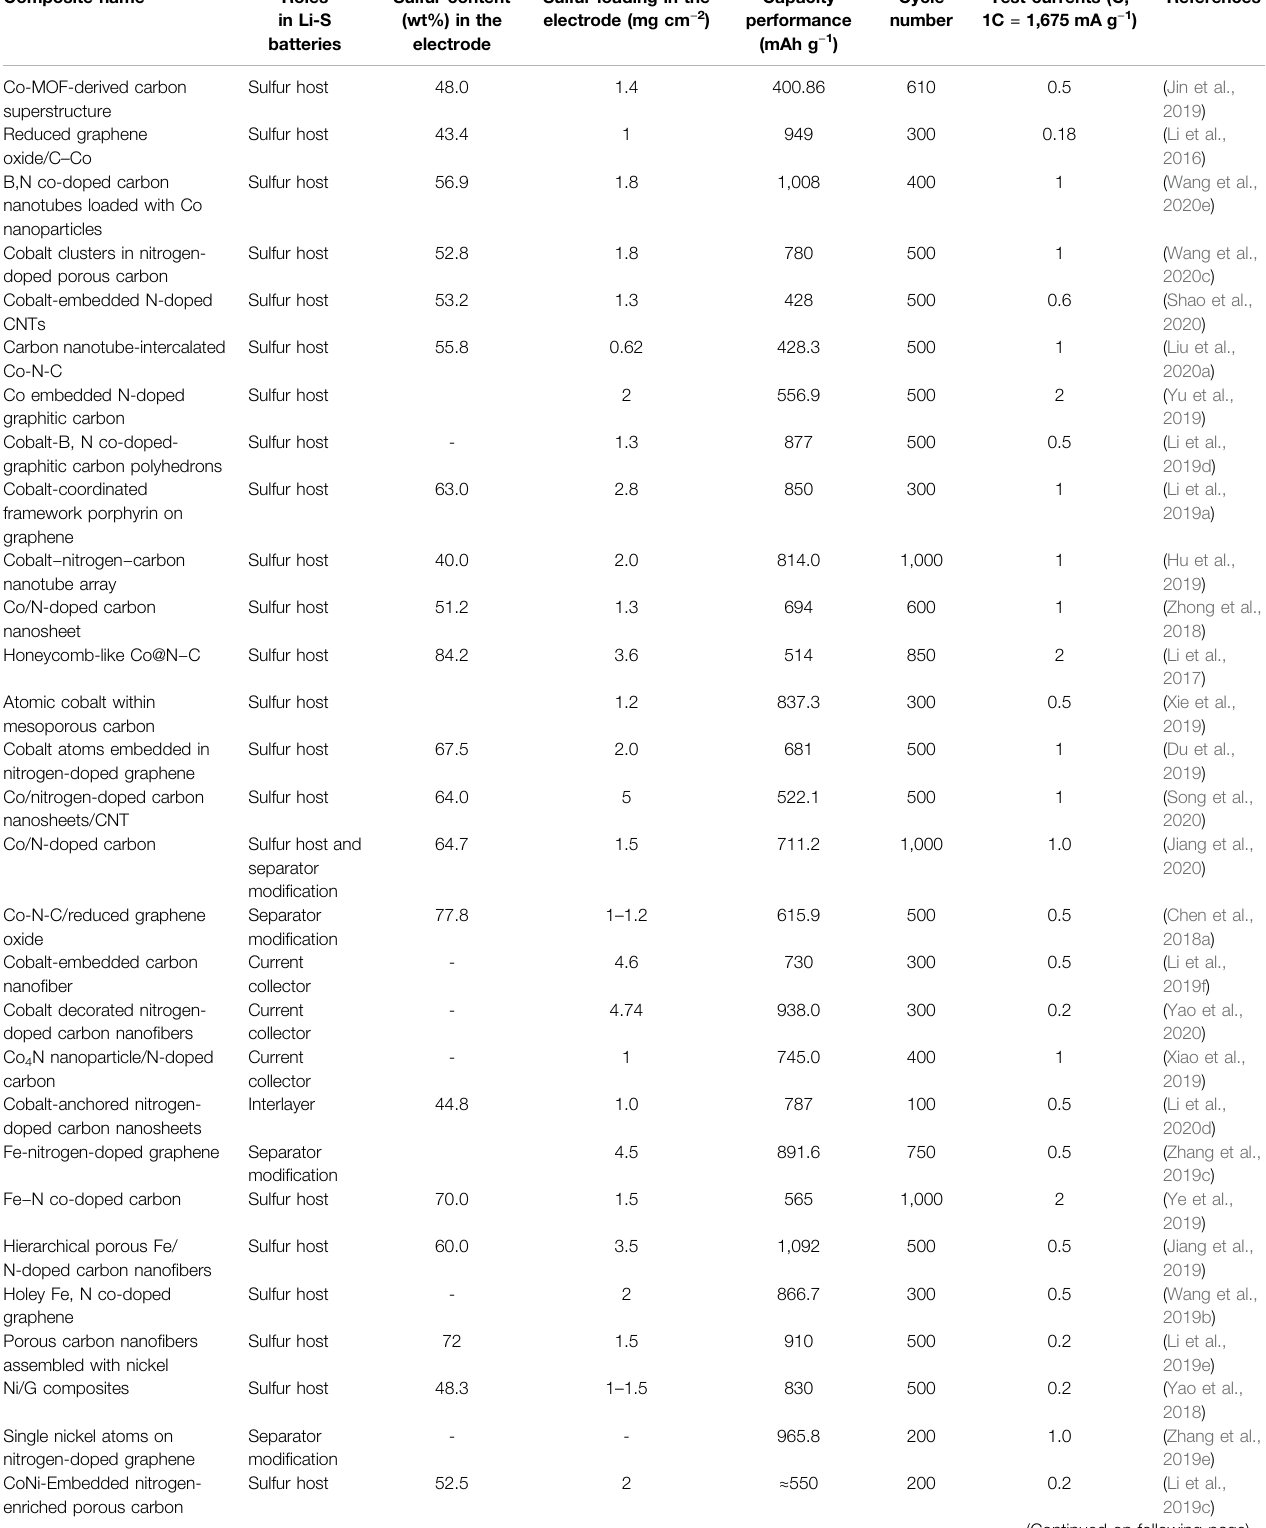
TABLE 2 | Various Fe/Co/Ni-decorated carbon materials for enhancing the performances of Li-S